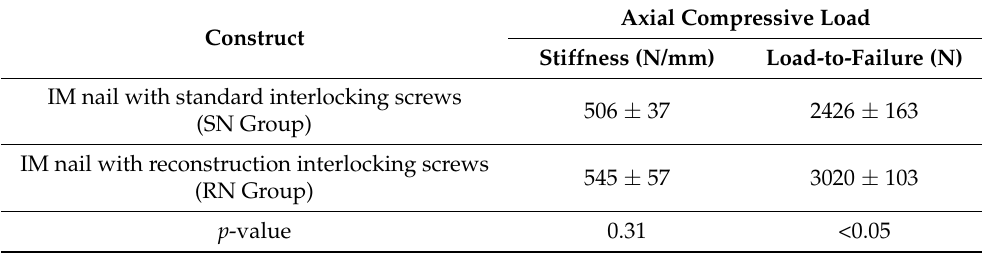
Table 1. Measurement results of construct stiffness under axial compressive